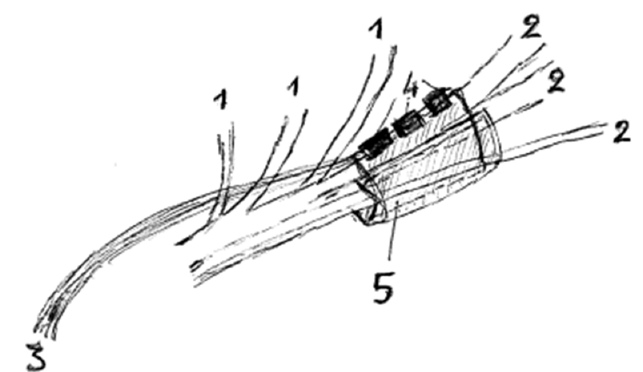
Figure 1. Drawing depicting the stimulating cuff electrode of the HGNS implant including the branches of the right-sided hypoglossal nerve, which innervated the protrusors and stiffeners of the tongue (1 = branches for the tongue retractor muscles-excluded from the cuff electrode), 2 = nerve branches for the protrusors and stiffeners of the tongue, 3 = cable connecting the stimulating cuff electrode to the impulse generator secured on the pectoralis major muscle, 4 = the three contacts of the electrode delivering the stimulation on the selected nerve branches, 5 = the cuff of the